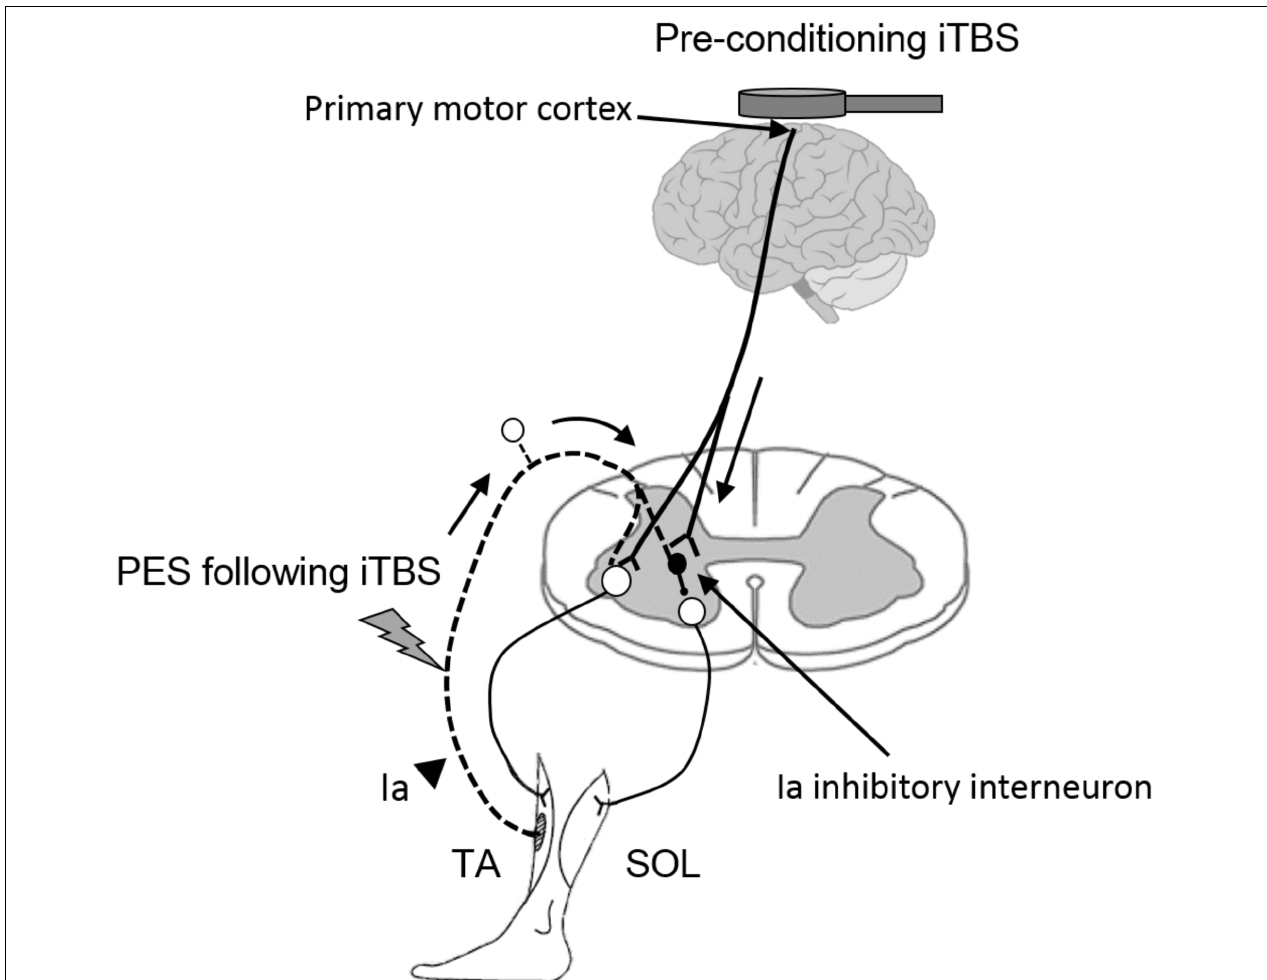
FIGURE 5 | Hypothetical model for the modulatory effect of iTBS over the motor cortex on the subsequent induction of spinal plasticity induced by PES. White circles in the spinal cord denote spinal motor neurons. Black circles denote Ia inhibitory interneurons. Pre-conditioning by using iTBS changes cortical excitability and the state of Ia inhibitory interneurons, which receive convergent input from the motor cortex. The pre-state changes in the interneurons enhance the induction and maintenance of spinal plasticity induced by PES. TA, tibialis anterior; SOL,